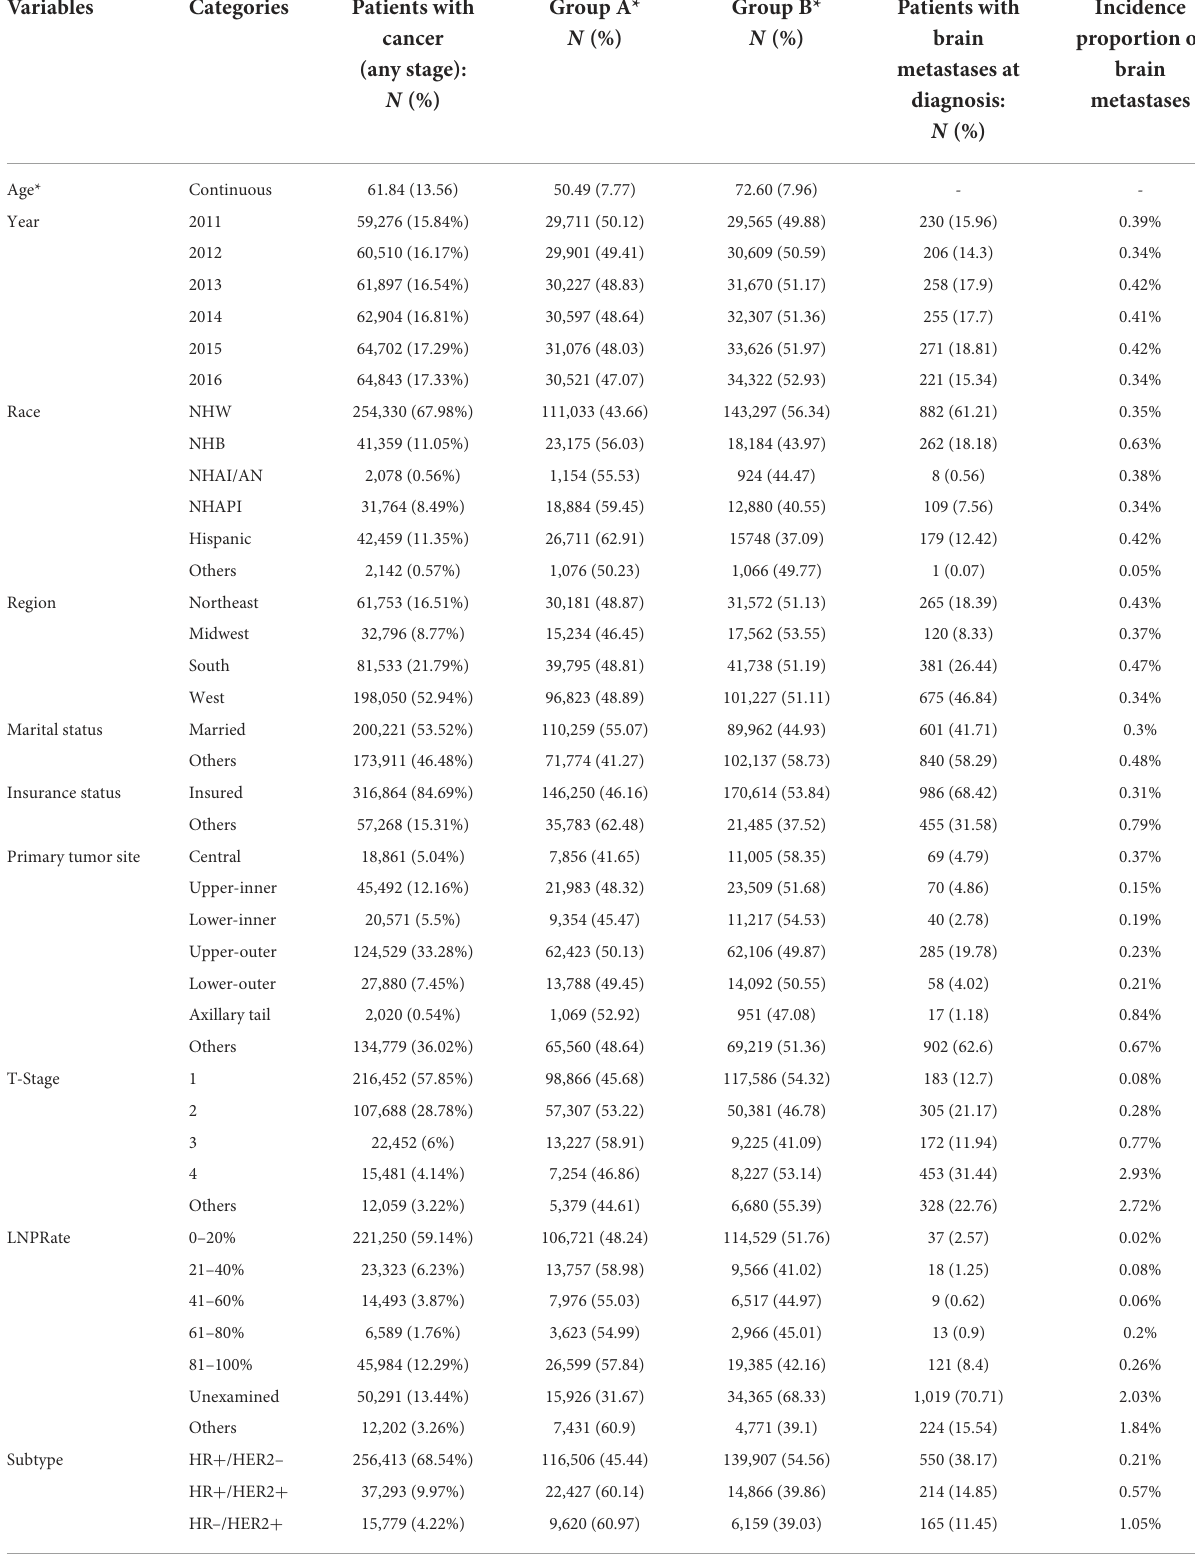
TABLE 1 Baseline characteristics of study